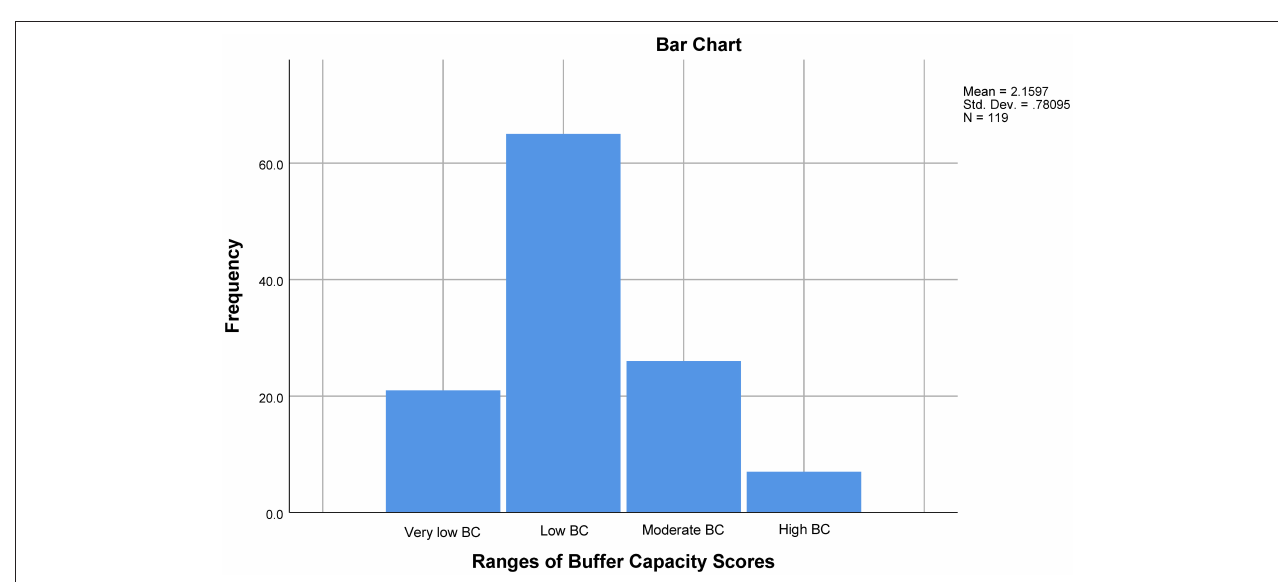
FIGURE 5 | Distribution of BC scores.